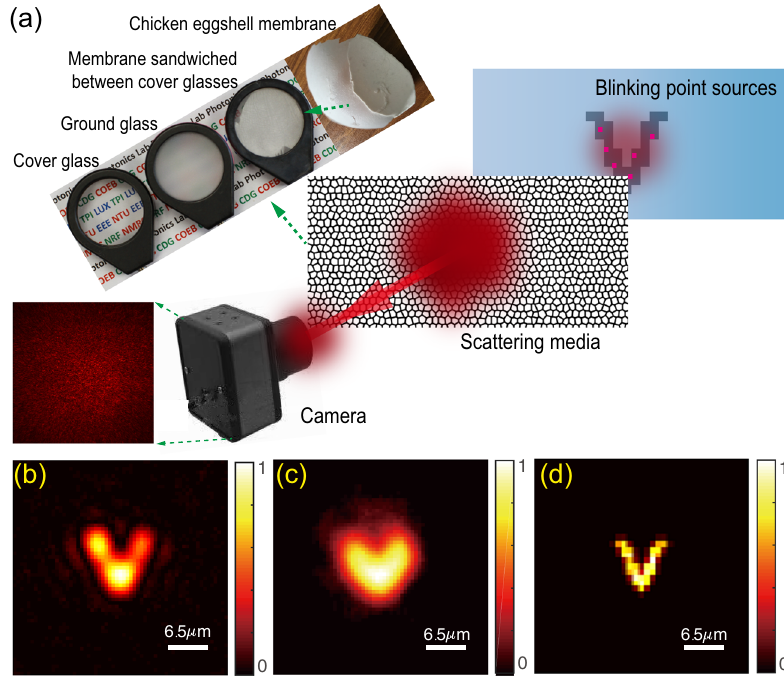
Fig. 1 Super-resolution imaging through scattering media with SOSLI in comparison to other imaging techniques. a Schematic of SOSLI where incoherent light from blinking point sources hidden behind various scattering media is scattered and then captured by a camera. b – d Experimental demonstrations of the current state-of-art invasive imaging, non-invasive imaging, and our super-resolution SOSLI, respectively, through the same scattering medium in the identical experimental